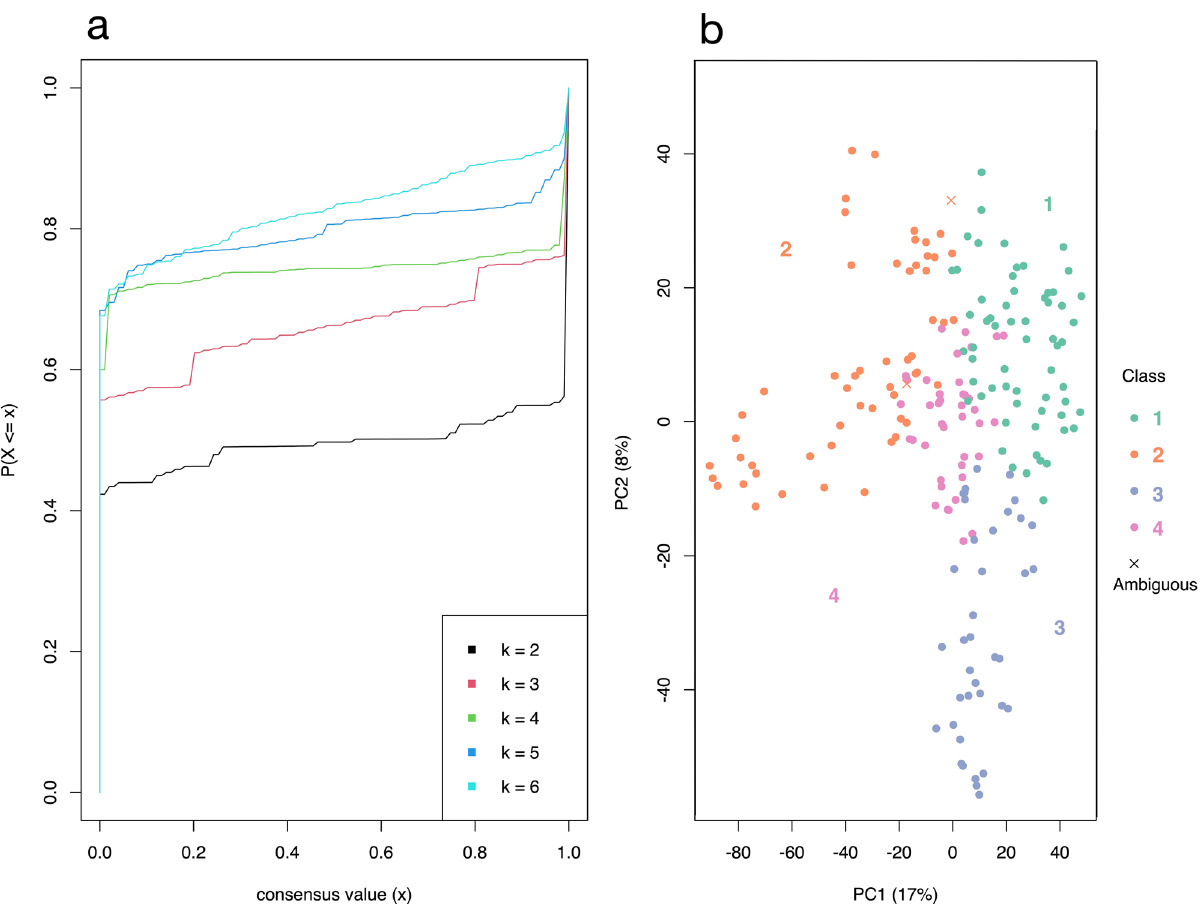
Figure 1. eCDF curve and PCA plot of the consensus clustering. ( a ) eCDF curve of the consensus matrix from partition by ATC:skmeans, a good k can be selected by aiming at the flatness of the eCDF curve. ( b ) PCA on 5000 rows with the highest ATC scores, 193 out of 195 confident samples were kept in their classes (silhouette >